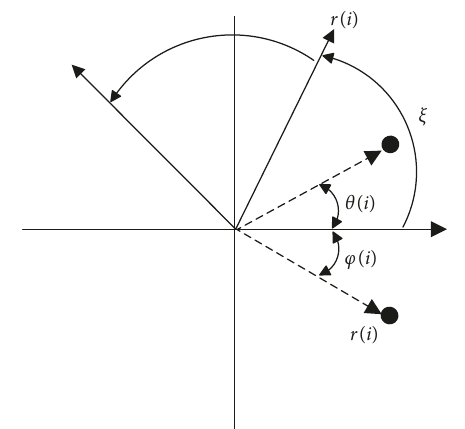
Figure 2: Principles of SDP